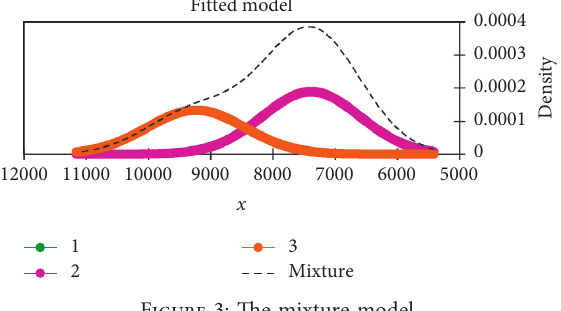
Figure 3: The mixture model.